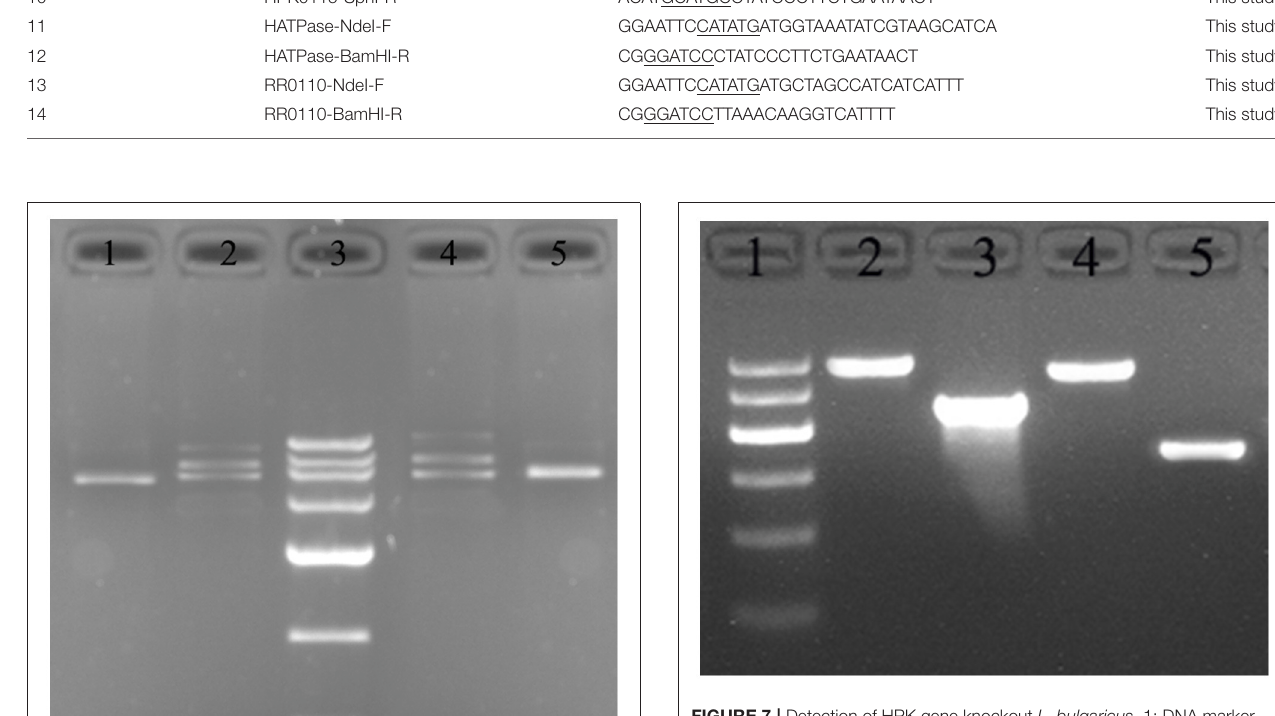
FIGURE 7 | Detection of HPK gene knockout L. bulgaricus. 1: DNA marker D2000 (100, 250, 500, 750, 1,000, 2,000); 2: PCR with Primers 5 and 6 from mutant 1 H0115 -1 genome; 3: PCR with Primers 5 and 6 from BAA-365 genome; 4: PCR with Primers 1 and 2 from mutant 1 H4160 -1 genome; 5: PCR with Primers 1 and 2 from BAA-365